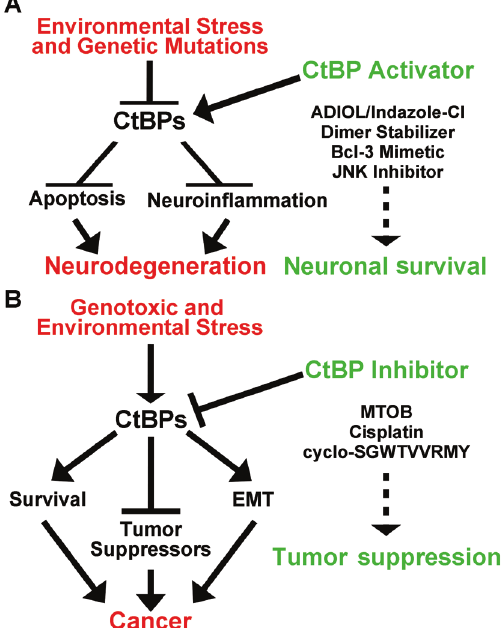
Figure 7 CtBPs as novel therapeutic targets for the treatment of neurodegenerative disease and